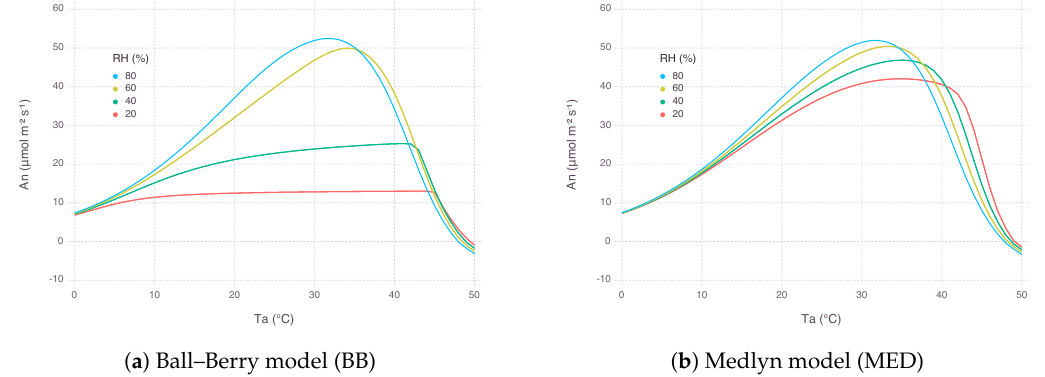
Figure 4. Net photosynthesis rate ( A n ) estimated by two stomatal conductance models over a range of air temperature ( T a ) from 0 ◦ C to 50 ◦ C at multiple levels of relative humidity (RH). Atmospheric CO 2 concentration ( C a ) was 400µbar and irradiance ( I ) was 2000µmol quanta m − 2 s − 1